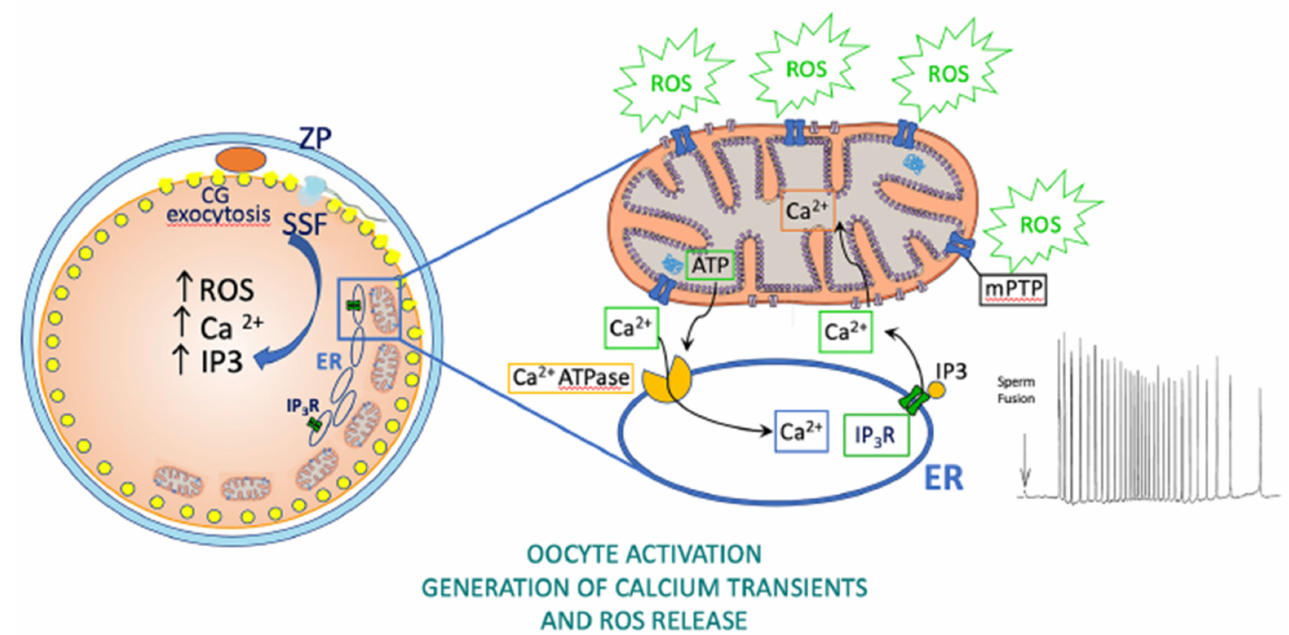
Figure 3. Roles of oocyte mitochondria in health. Production of ATP and ROS by oocyte mitochondria is involved in fertilization and embryo development. Upon gamete fusion, diffusion of a sperm soluble factor (SSF) into the oocyte cytosol generates IP3 which binds endoplasmic reticulum (ER) IP3 receptors (IP3R) causing cytosolic Ca 2+ oscillations. Cytosolic Ca 2+ rise drives numerous events among which the exocytosis of cortical granules (CG) and the consequent hardening and polyspermy block of the zona pellucida (ZP). Ca 2+ potentiates the mitochondrial production of ATP which is needed for Ca 2+ reuptake into the endoplasmic reticulum through Ca 2+ ATPase allowing the recovery of cytosolic Ca 2+ levels after each transient. Evidence in oocytes from different species indicates that sperm-induced Ca 2+ rise triggers a release of ROS from mitochondria which is required for embryo